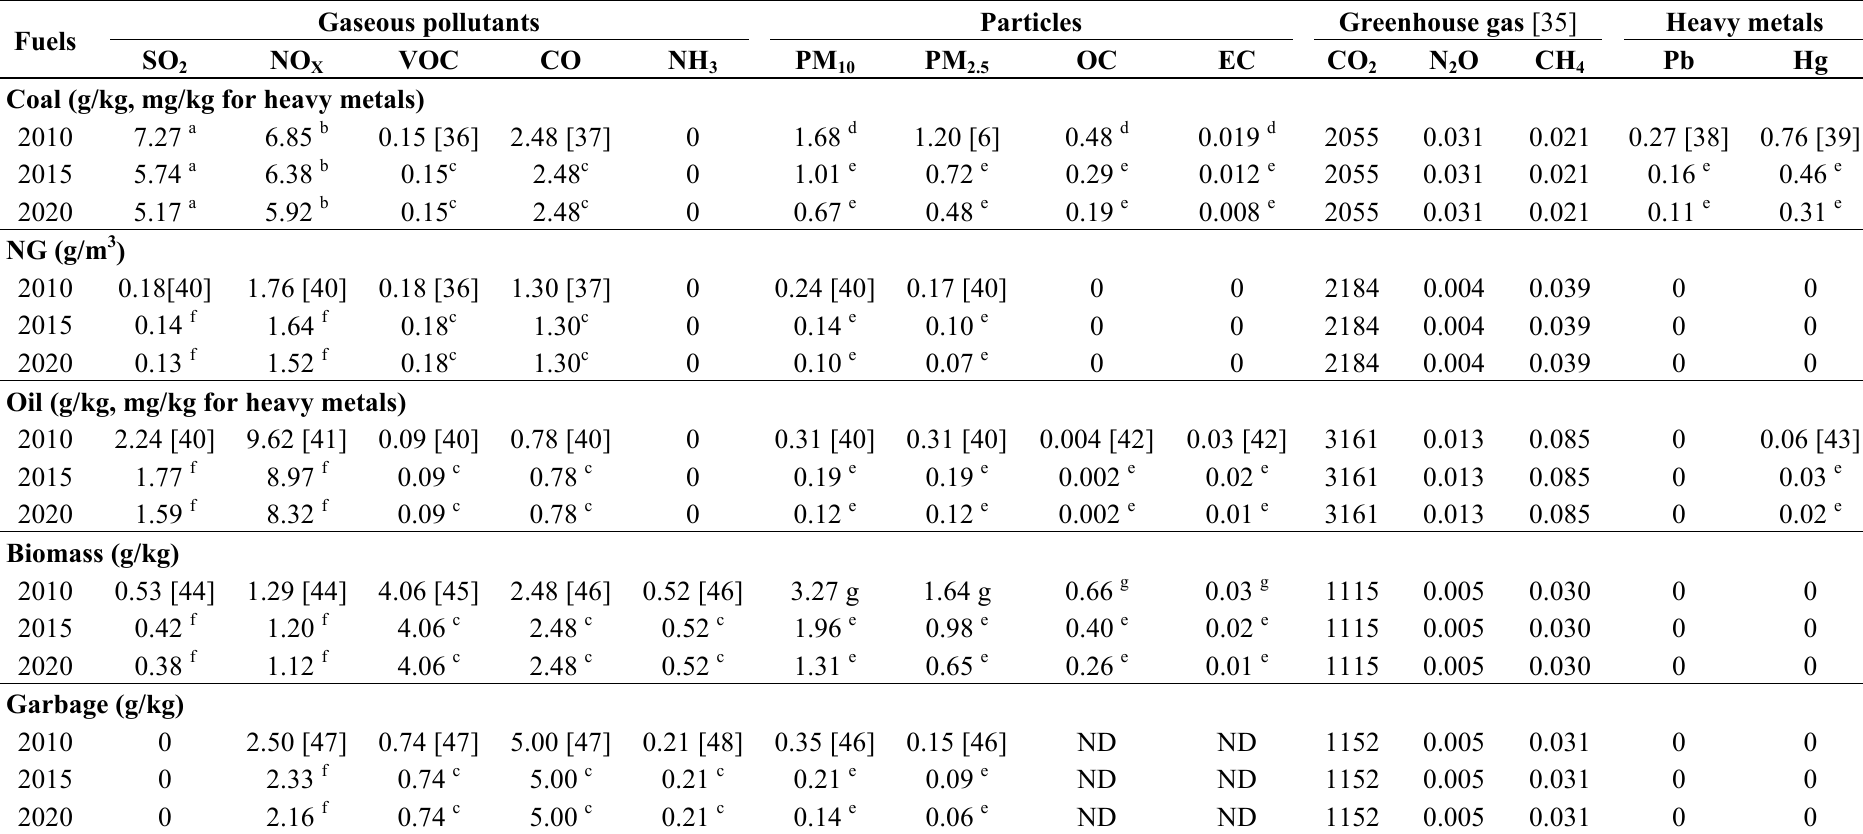
Table 7. Emission factors of different fuels used to generate